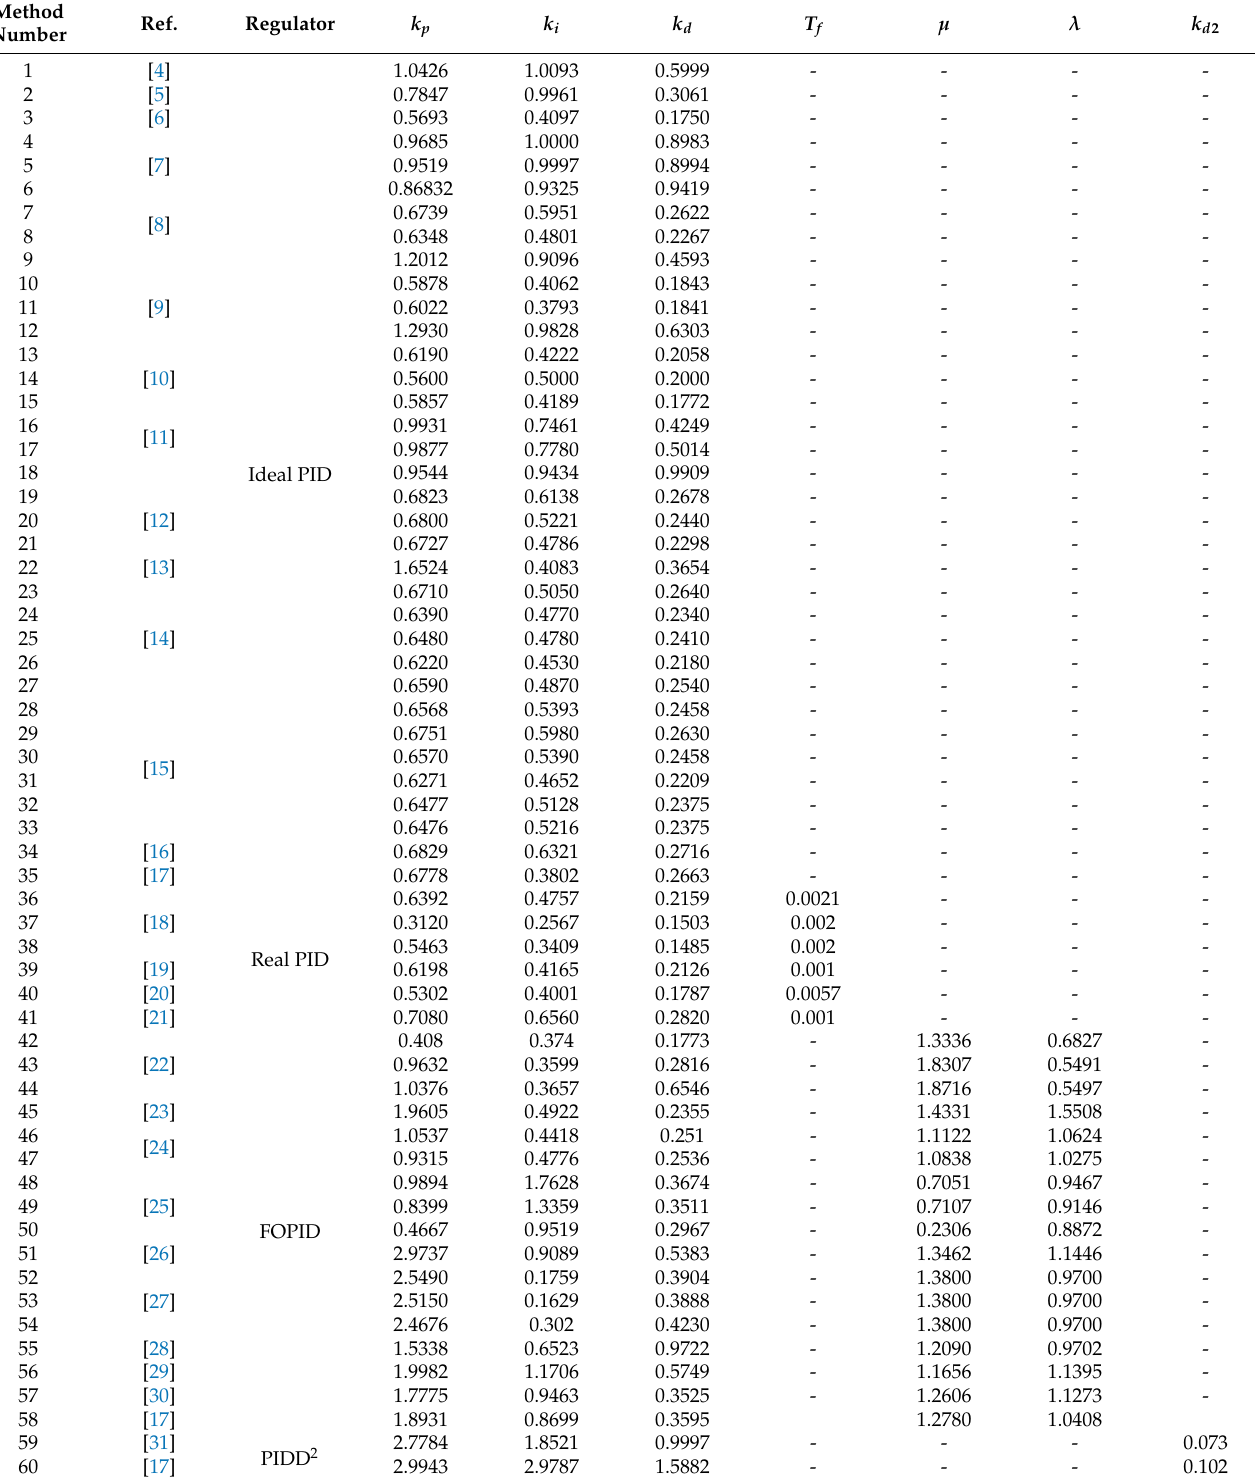
Table 1. Summary of the optimal parameters obtained using different controllers/algorithms in the investigated works. Method